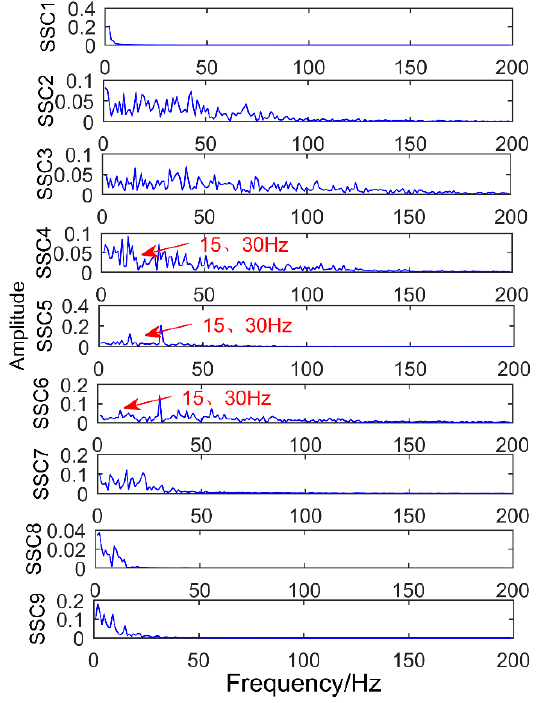
Figure 19. Envelope spectrum of the decomposition results obtained by SSD.